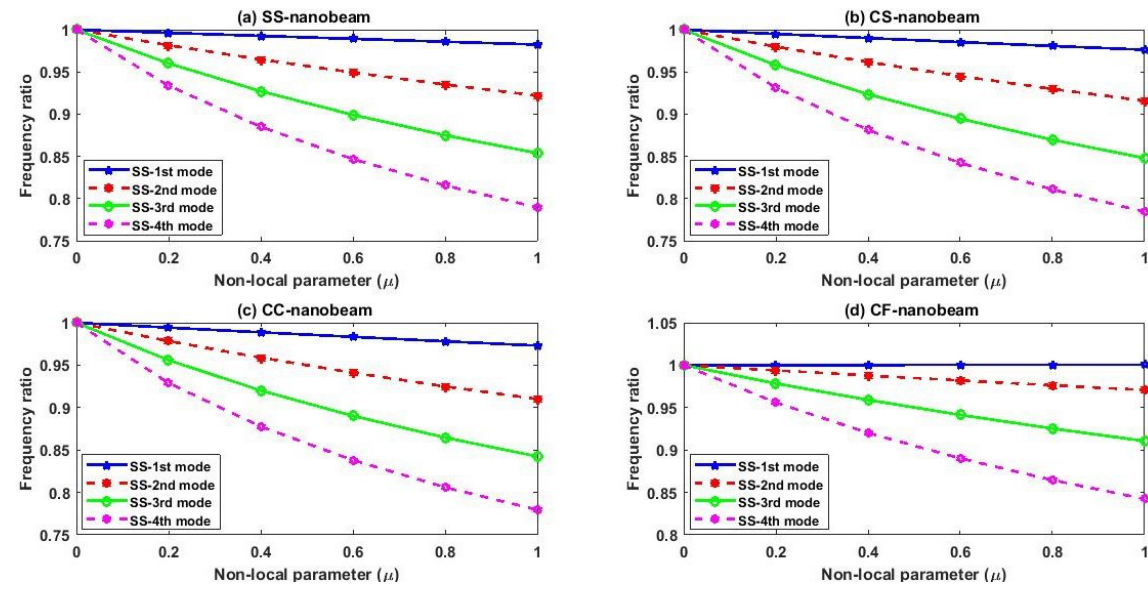
Figure 2: Variation of frequency parameter with nonlocal parameter Table 10: Frequency parameter for SS case for different nonlocal parameter